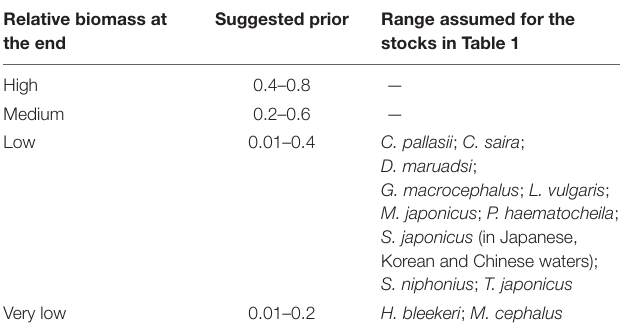
TABLE 4 | Suggested ranges of the fraction B end / k for the period prior to catches being available*. Relative biomass at Suggested prior Range assumed for the the end stocks in Table